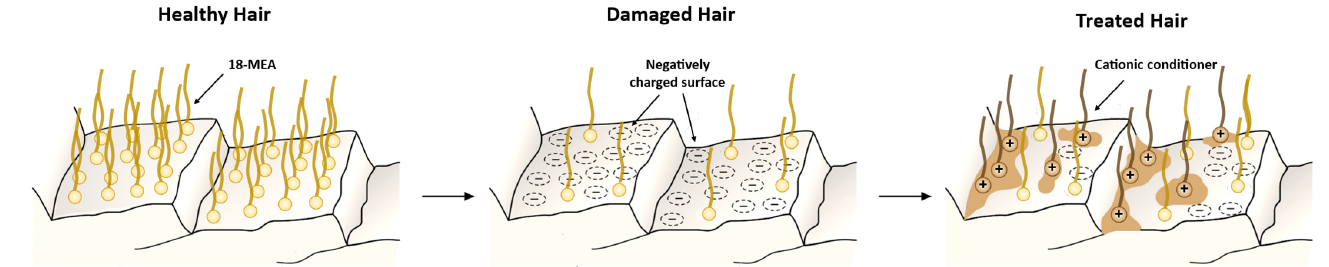
Figure 8. Negatively charged hair and the deposition of positively charged conditioner on the cuticle surface. Adapted from reference [50].